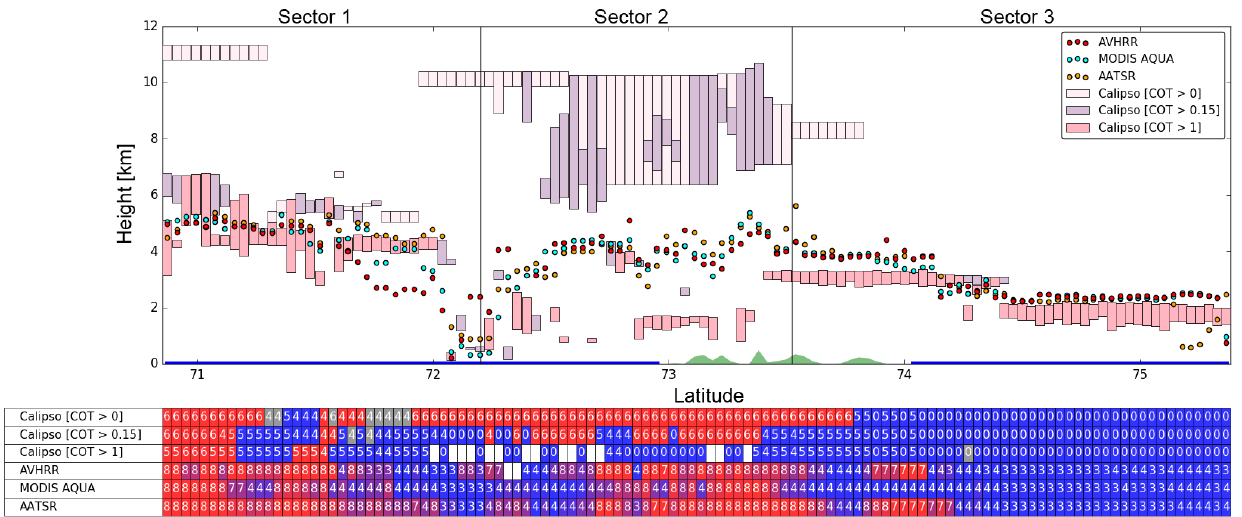
Figure 14. Study area SIB (Siberia). As Fig. 10, but on 27 July 2008, 08:10LST ( n =